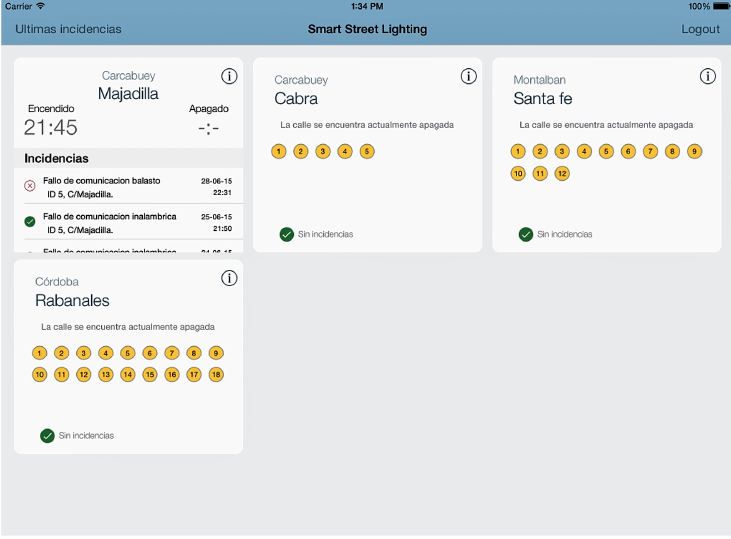
Figure 7. App screenshot with information on incidents for the maintenance technician.